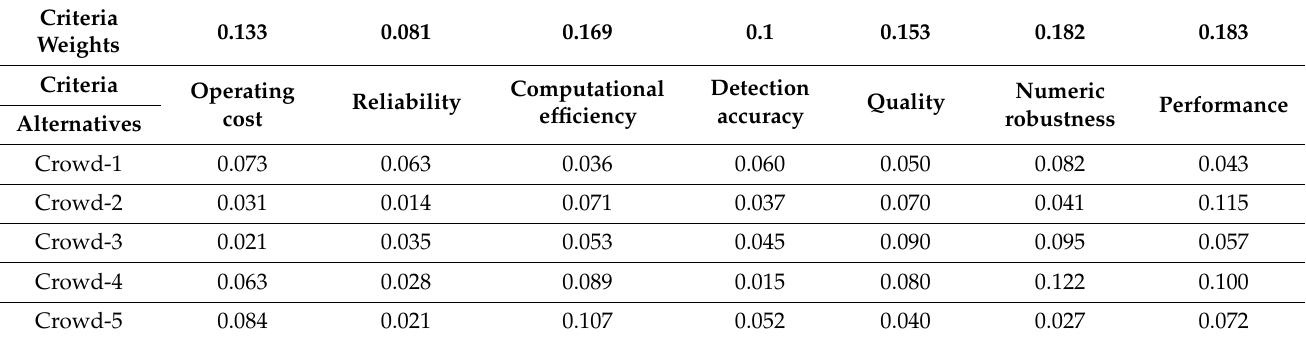
Table 8. Weighted NDM.